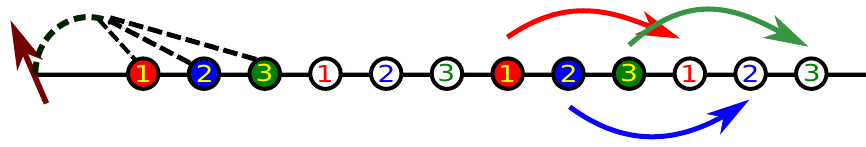
Figure 2 . Schematics of the DMRG simulation for the SU(3) model. The black circles represent interleave lattice sites where di(cid:11)erent colors are separated and labeled as 1 ; 2 ; 3. The colored dots represent conduction fermions and the curly arrows show some hopping terms. The dotted lines show spin-spin exchange interaction between the SU(3) spin and the (cid:12)rst physical site. end, we have performed extensive numerical calculations on the Hamiltonian. The Hilbert space can be divided into subspaces labeled by the numbers of fermions in each color N . f(cid:27) The subspaces of our interest are those for which all N have the same value (which is f(cid:27) just M for j (cid:9) i ). If the dimension of a subspace is not too large, the lowest eigenvalue